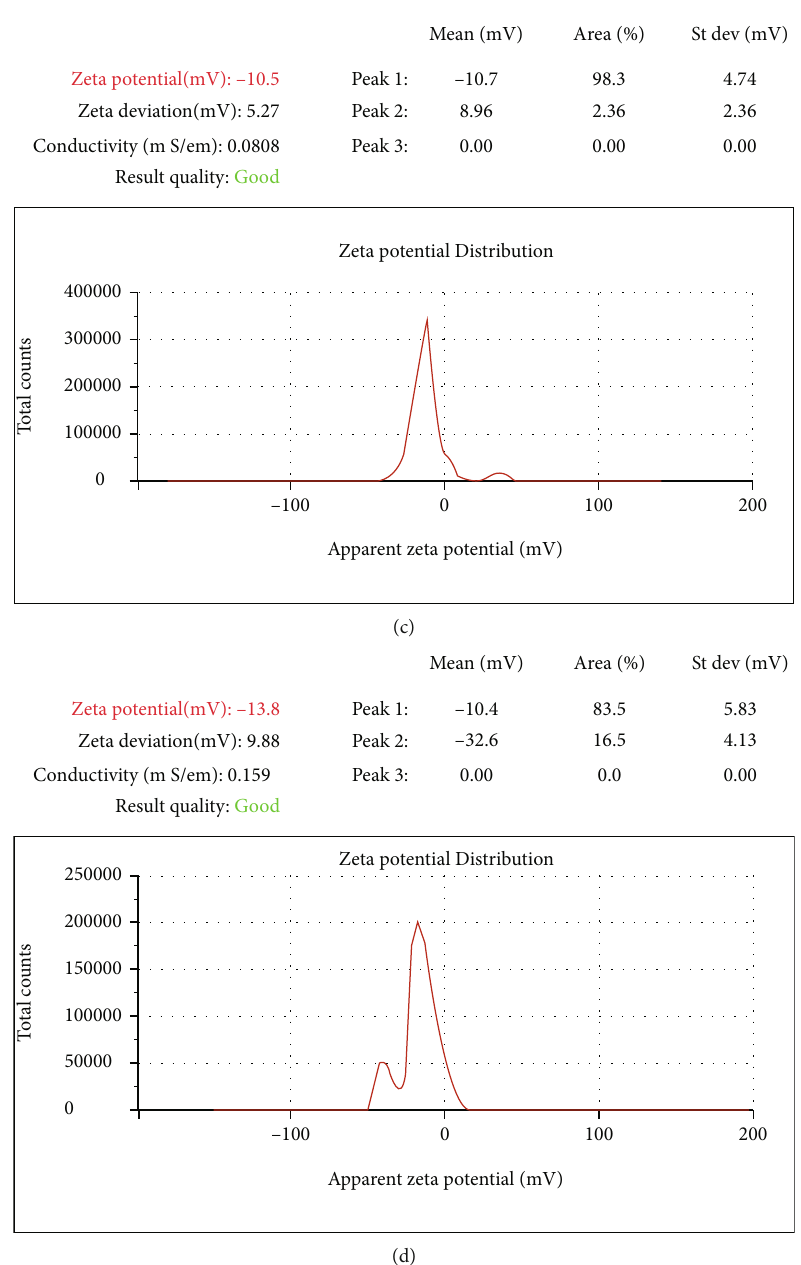
Figure 4: Size distribution by intensity of (a) niosomes and (b) niosome-selegiline and zeta-potential of (c) niosomes and (d) niosome- selegiline. Table 2: Physicochemical characterization of niosomes and selegiline-niosomes.